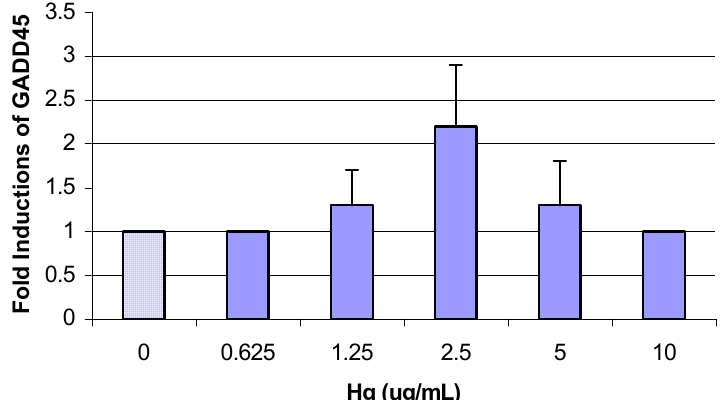
Figure 6. Fold induction of GADD45 in HepG means ± SDs, n =